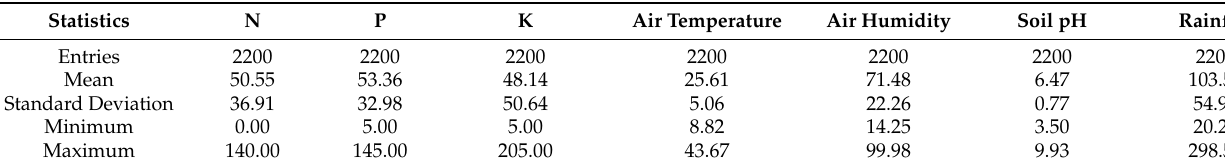
Table 3. Statistical summary of our dataset.